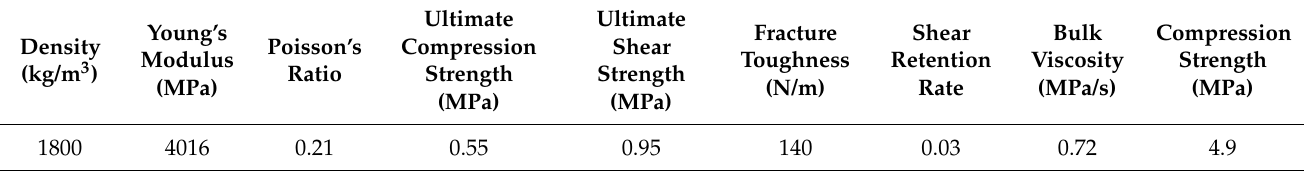
Table 3. Parameters of mortar material